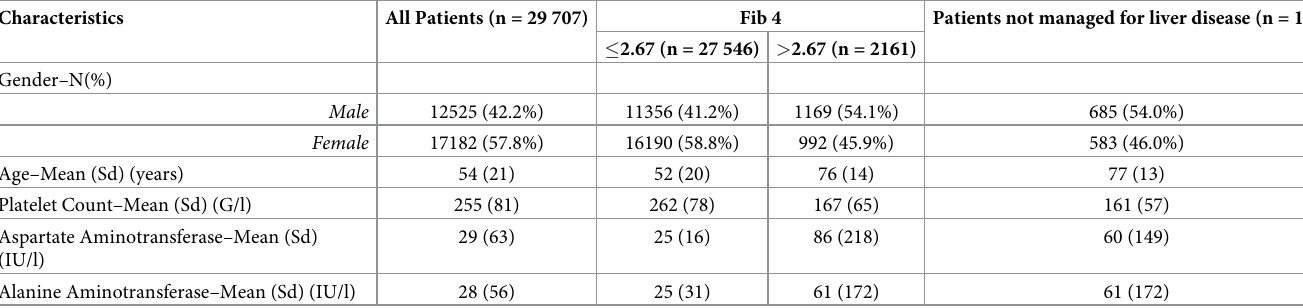
Table 1. Characteristics of the patients.